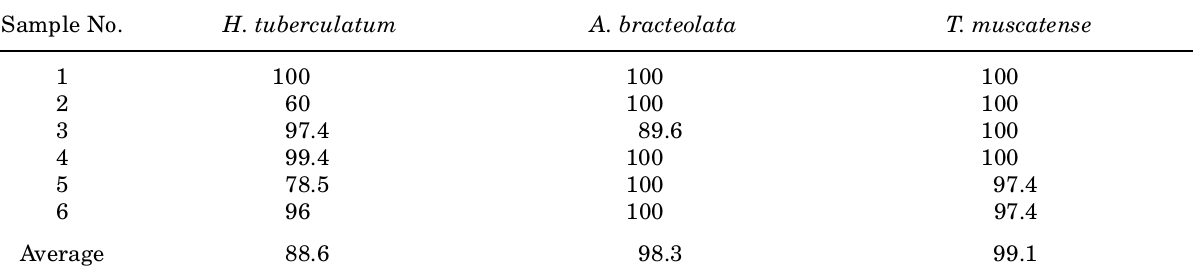
2. Survival (expressed as percentage of inhibition) of fungi irradiated with Gamma rays (905.4 Gy). Sample